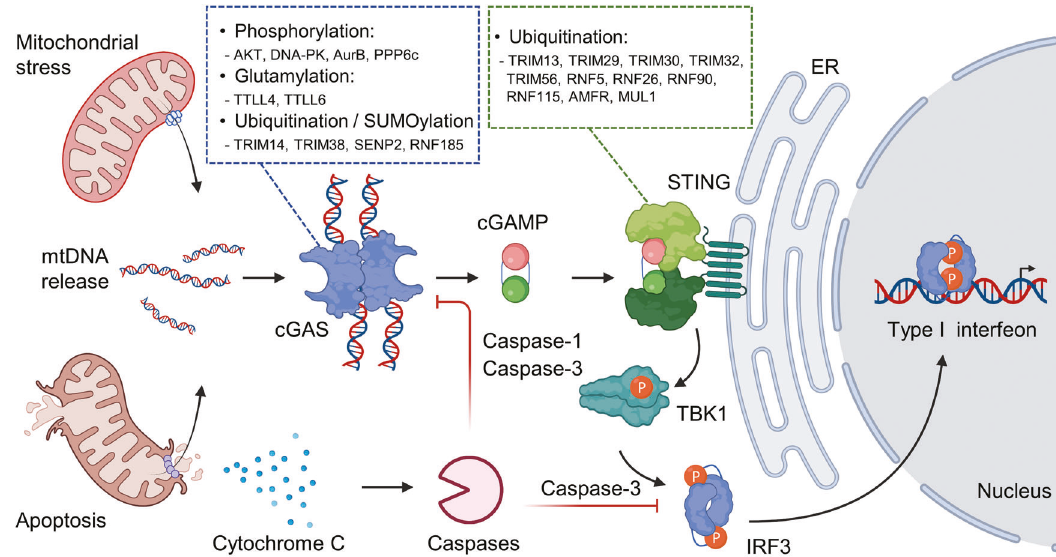
Fig. 5 Posttranslational modi fi cation in the cGAS-STING pathway. Mitochondrial stress induces the release of mtDNA and subsequently activates the cGAS-STING pathway. This signaling pathway can be regulated by various posttranslational modi fi cations and can also be suppressed by caspases during